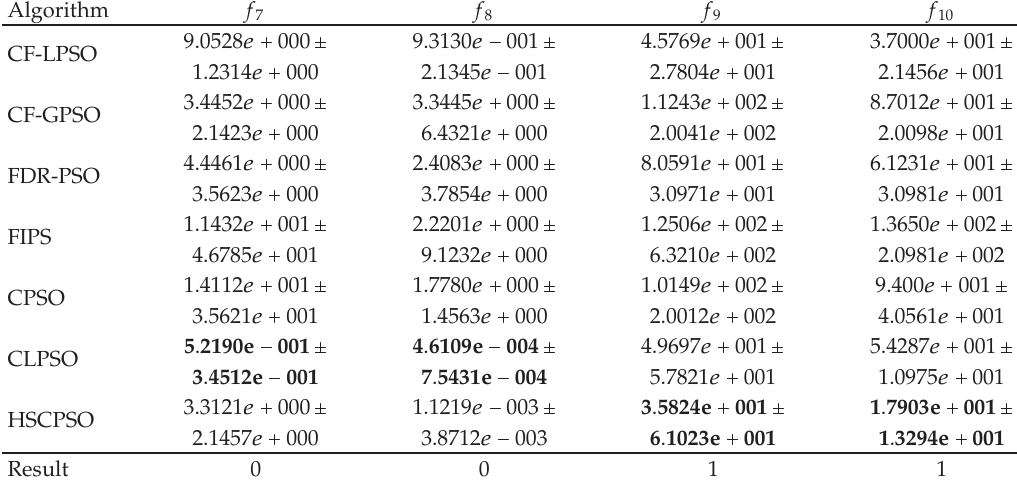
Table 5: Means after 6 10 4 function evaluations for the rotated test (cid:4)